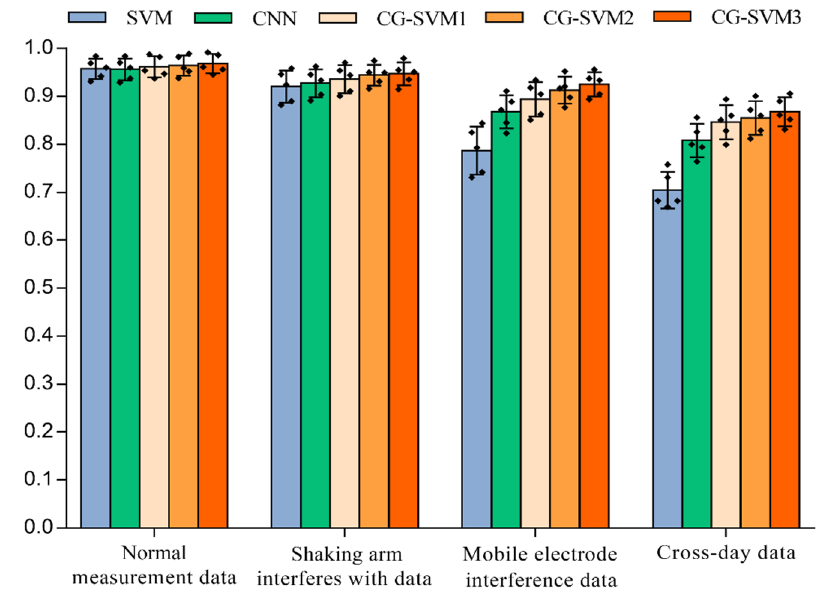
Figure 12. Comparison of network classification accuracy, the vertical lines depict the respective 95% confidence intervals, the black squares in the figure represent the distribution of sample points.